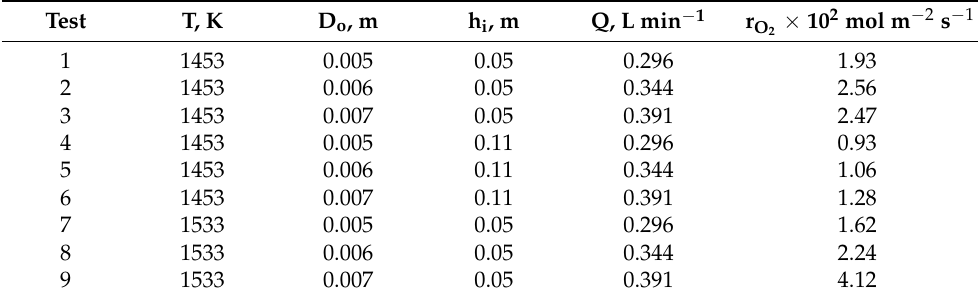
Table 6. Results of the overall specific rate of oxygen consumption for the white metal conversion process under the experimental conditions